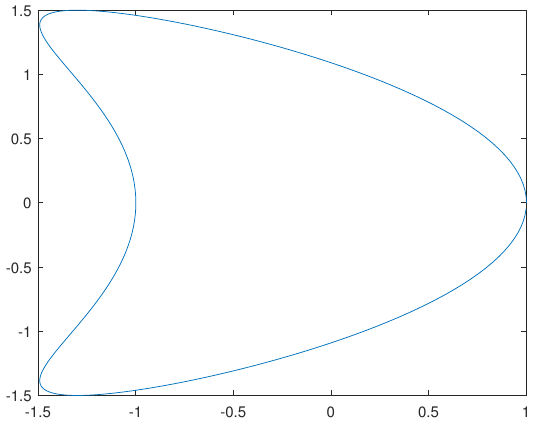
Figure 5. The shape of domain for Example 4.